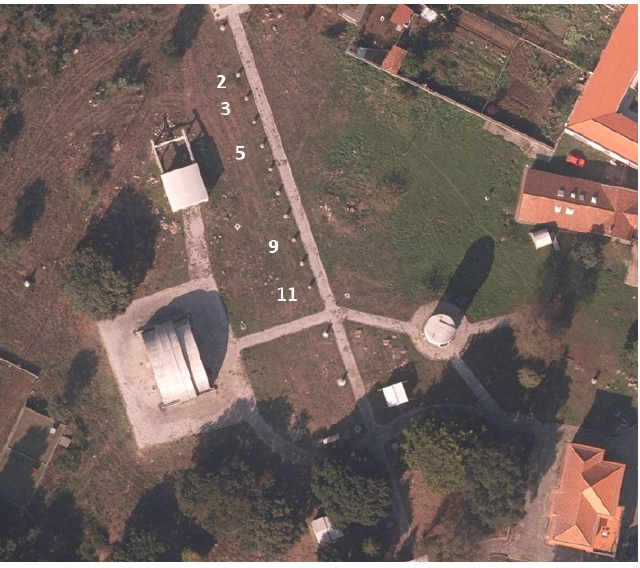
Figure 1. Calibration base at Astronomical Observatory of the University of Porto.